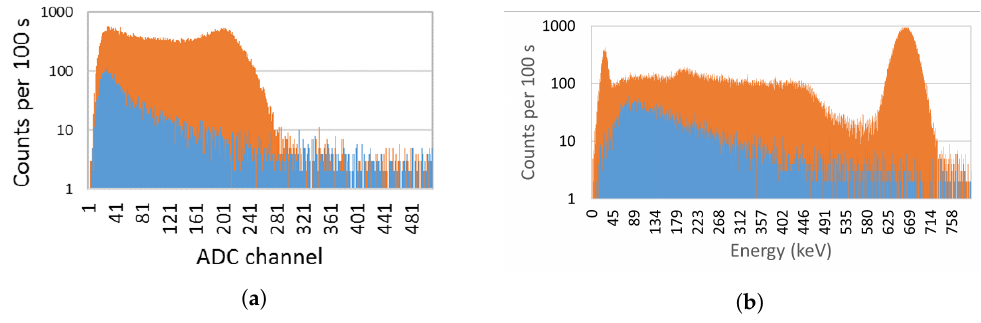
Figure 15. Gamma-ray spectra of a 8.5 kBq 137 Cs source next to the detector window (orange color) and background (blue color) obtained with the: ( a ) EJ-200 scintillator (total counts: 181,780 ± 426; background counts: 12,538 ± 112). ( b ) CsI(Tl) scintillator (total counts: 310,116 ± 557; background counts: 26,038 ±